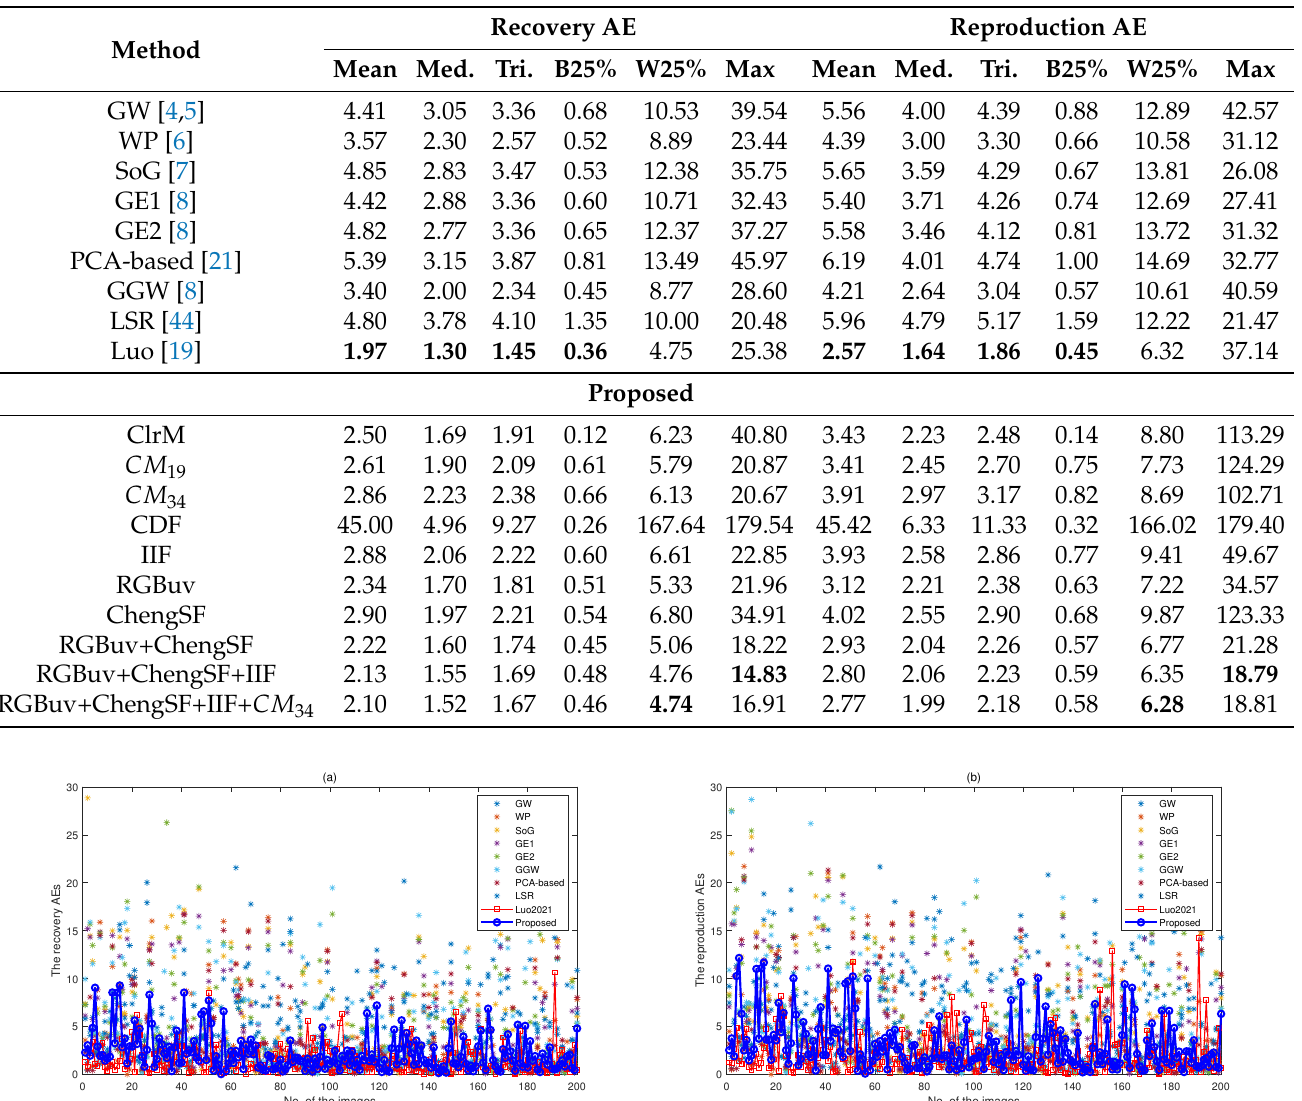
Table 5. Comparative performance metrics between the proposed method and some conventional methods, with training and testing on the combination of the Gehler-Shi and Cube+ datasets.